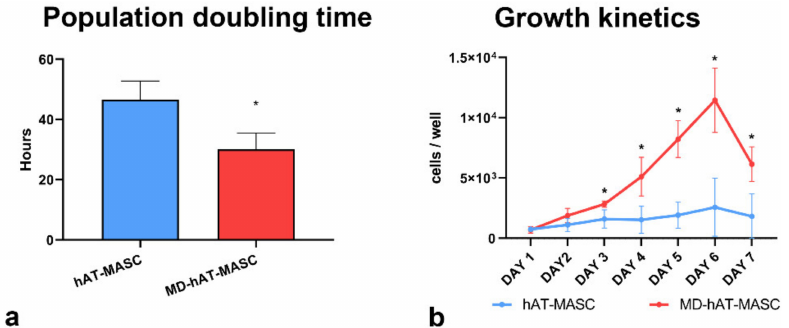
Figure 3. Proliferation of ASC cells: population doubling time ( a ) and growth kinetics ( b ). The results are expressed as mean ± standard deviation. * p < 0.05 vs. ASC.